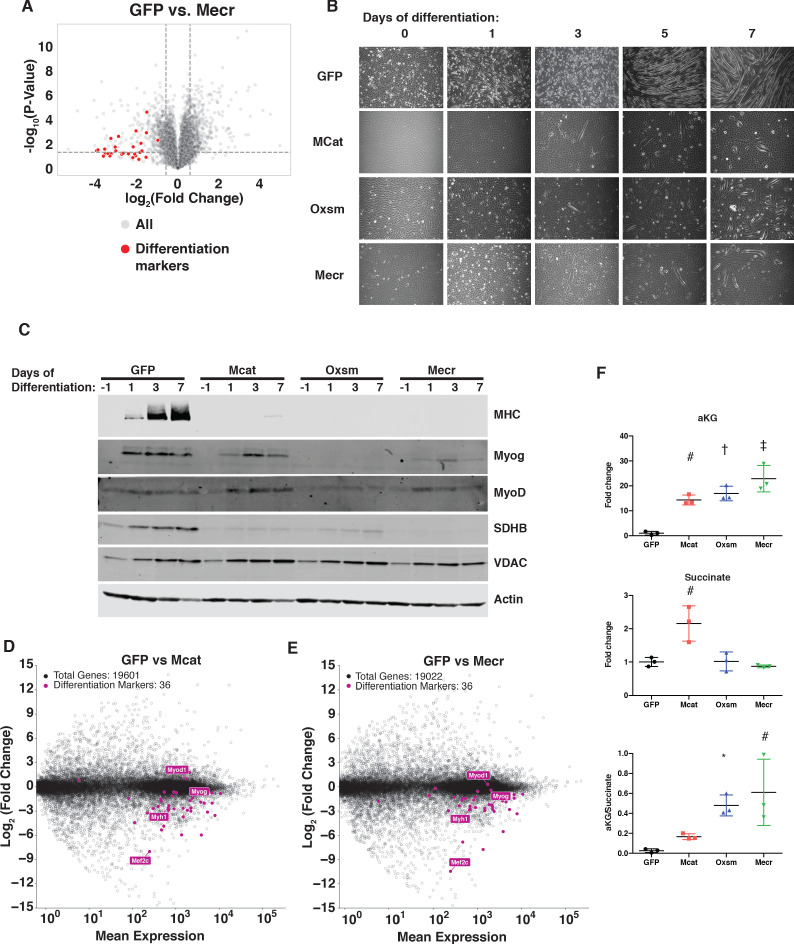
MtFAS is required for skeletal myoblast differentiation.(A) Volcano plot of quantitative proteomics experiment showing Mecr mutant samples (n = 4) vs. GFP (n = 4) controls; all proteins (gray), and proteins associated with the differentiated skeletal muscle lineage (red). Dashed lines indicate cutoffs for significance at -log10(p-value) = 1.3 and log2(Fold Change) = +/- 0.59. (B-C) Cells of the indicated genotypes were plated and grown for 24 hr under proliferative conditions (day −1), then switched to 2% horse serum differentiation medium at 95% confluency (day 0). Medium was replaced daily for the indicated number of days. Plates were imaged (B) or whole cell lysates were collected at the indicated time points, separated by SDS-PAGE, and immunoblotted for the indicated proteins (C). (D-E) Quadruplicate samples from mtFAS mutant cells and controls were grown under proliferative conditions to 95% confluency then switched to 2% horse serum differentiation medium for 24 hr. Total RNA was isolated, used as input for mRNA library prep, and sequenced. Resulting data were aligned to the mouse genome and analyzed for differential expression. Transcripts for differentiation related proteins from panel (A) are shown in purple vs. all other transcripts (gray). (F) Relative steady state pool sizes of the indicated metabolites in mtFAS mutant cell lines vs. GFP controls grown in proliferative conditions from steady-state LC-MS metabolomics analysis. *=p < 0.05, #=p < 0.01, †=p < 0.001, ‡=p < 0.0001, error bars are SD.